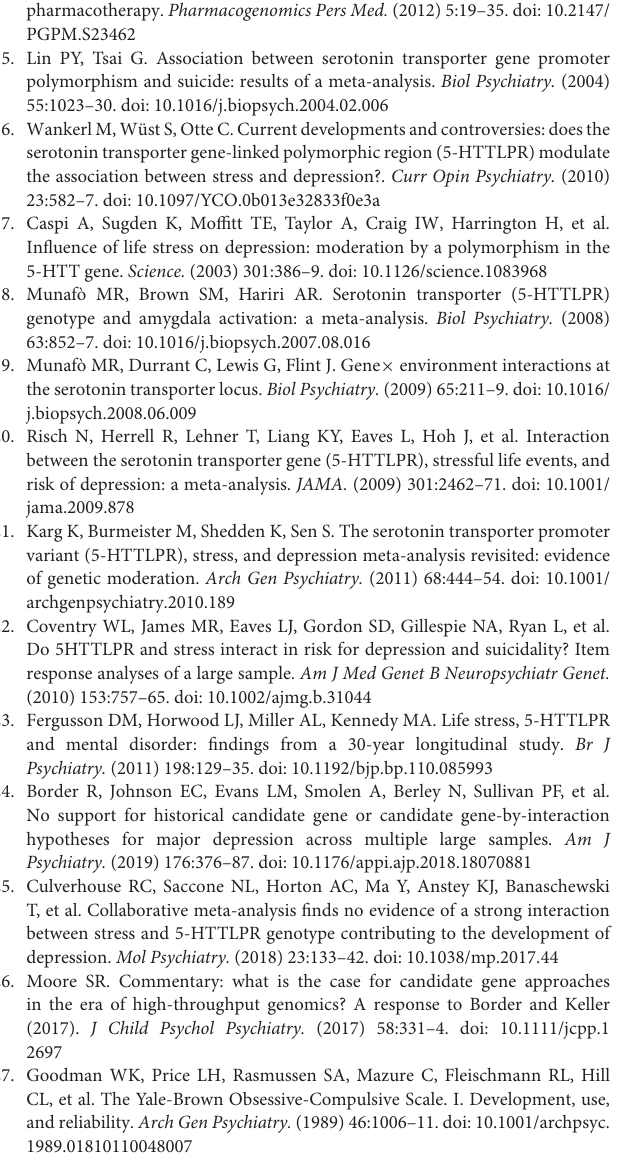
Supplementary Table 1 | Anonymized dataset. Supplementary Data Sheet 1 | Code for